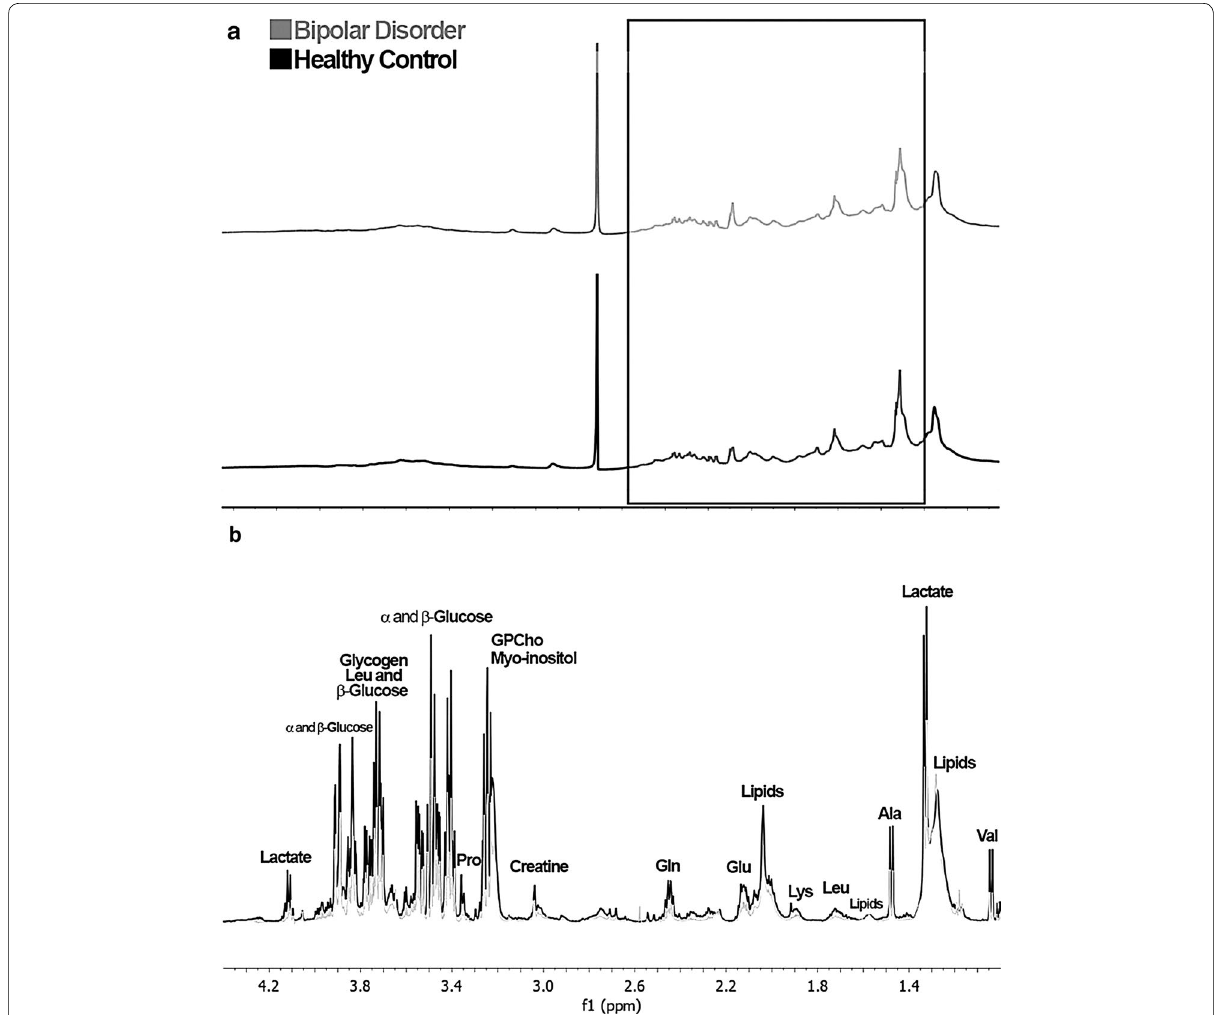
Fig. 1 a 1 H NMR Spectra with water suppression (Pulse sequence: p3919gp, ns Spectral region highlighted δ 4.40 to 1.00 with higher loadings. b 1 H NMR Spectra recorded with T 2 ‑filter (Pulse sequence: cpmgpr1d, ns blood serum sample from HC ( black ), and BD group ( gray ). Assignments: Lactate (δ 1.33 and 4.11), glucose (δ 3.41, 3.46, 3.77 and 3.82), leucine (Leu; δ 1.71 and 3.73), proline (Pro; δ 3.34), glycerylphosphocholine (GPCho; δ 3.24), myo ‑inositol (δ 3.25), creatine (δ 3.03), glutamine (Gln; δ 2.44), gluta‑ mate (Glu; δ 2.14), lipids (δ 1.29 and 2.04), lysine (Lys; δ 1.68), alanine (Ala; δ 1.47), valine (Val; δ